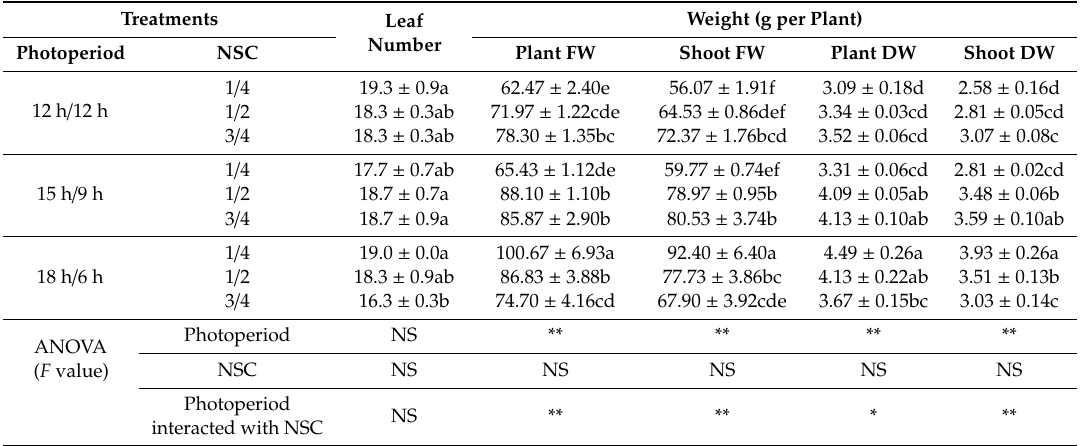
Table 2. Changes of growth lettuce under the interaction of photoperiod and nutrient solution concentrations